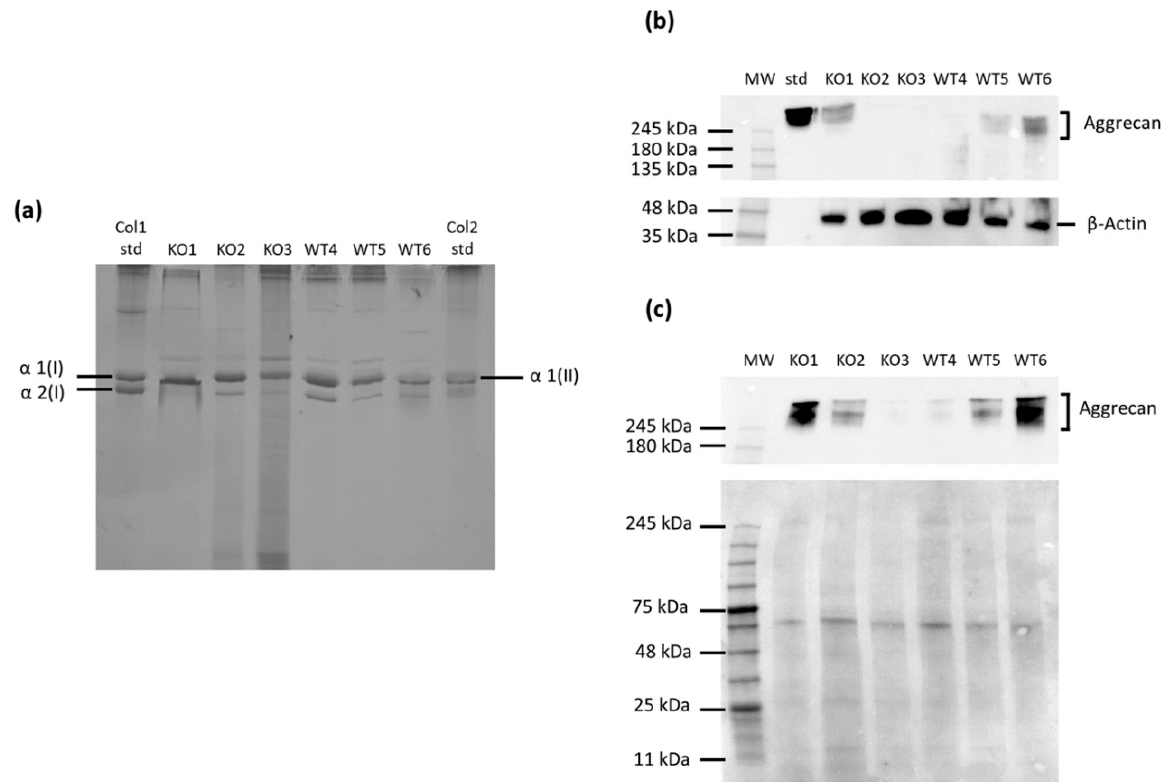
Figure 2. Synthesis of extracellular matrix proteins in immortalized chondrocytes. ( a ) 6% SDS-PAGE of collagen purified by pepsin digestion from the medium showed that all cell lines synthesized type II collagen, but a very small amount of type I collagen was present in wild-types and two Cant1 knock-out samples. Col1 std = pepsin solubilized type I collagen standard and Col2 std = pepsin solubilized type II collagen standard. ( b ) Western blot of proteins extracted from cell layer of immortalized chondrocytes was performed with specific antibodies against aggrecan core protein and against β -Actin as internal control. The blot is representative of three independent experiments. MW = molecular weight and std = aggrecan core standard. ( c ) Western blot of proteins extracted from the medium was performed with a specific antibody against the aggrecan core protein; protein stain of the PVDF membrane with swift membrane stain was used as loading control. The blot is representative of two independent experiments. MW = molecular weight. Both cell layer and medium Western blots showed huge variability of aggrecan synthesis among immortalized chondrocytes; KO1 and WT6 were the Cant1 knock-out and wild-type samples, respectively, that synthesized more aggrecan. The full original gel and Western blots are reported in Supplementary Materials Figure